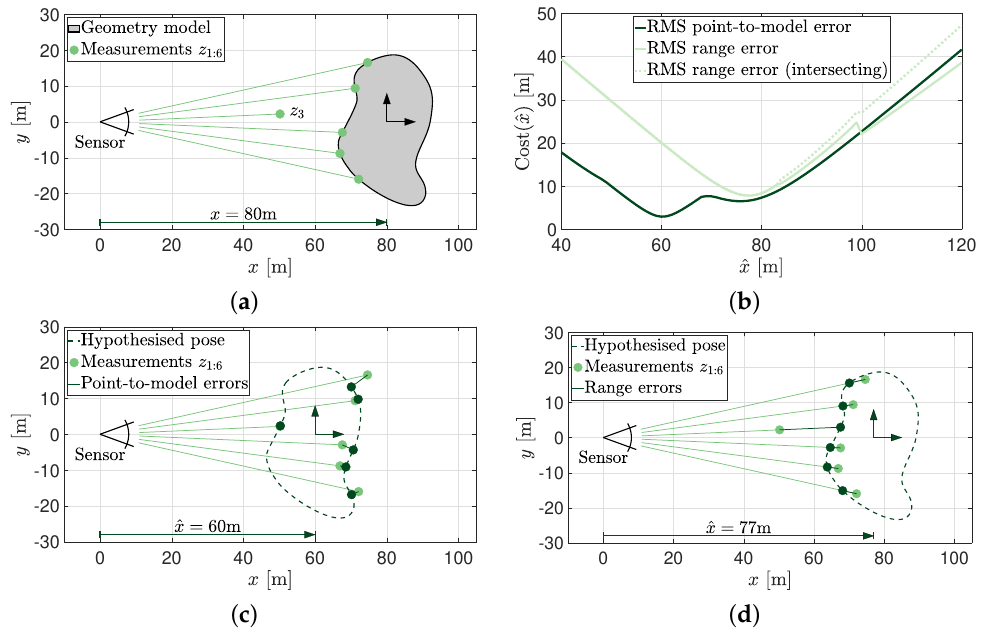
Figure 2. Cost-based metrics and their ability to provide for the estimation of object pose when provided with a corrupted measurement set. ( a ) One of the range measurements, z 3 , is altered to simulate a spurious measurement. ( b ) RMS point-to-model and range error cost metrics when the measurement z 3 is altered. ( c ) The most likely pose hypothesis using the point-to-model cost metric. ( d ) The most likely pose hypothesis using the range error cost